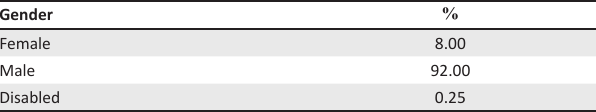
TABLE 4: Gender of the study population. Gender % Female 8.00 Male 92.00